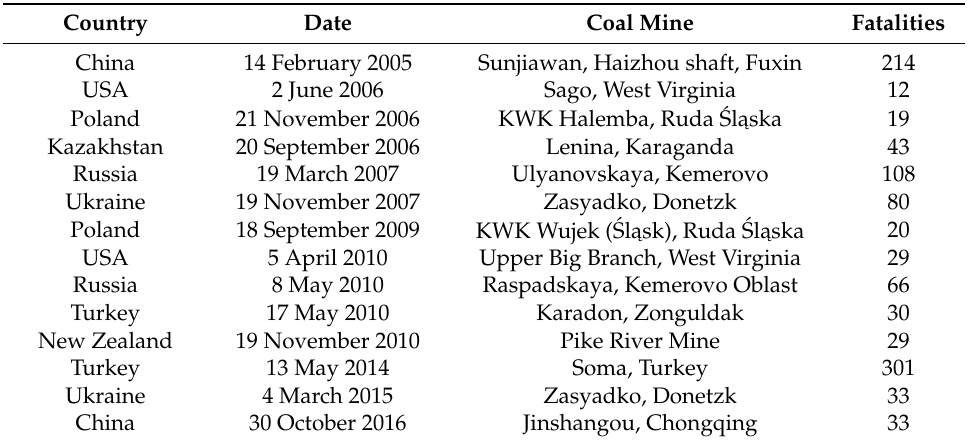
Table 1. Major underground coal mine explosion incidents after